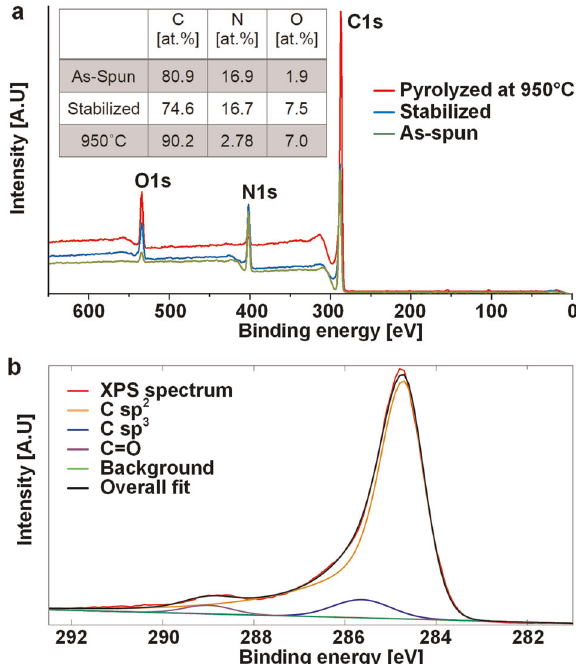
Fig. 3 XPS analysis. a Spectra of as-spun nano fi bers, stabilized nano fi ber bundles and nano fi ber bundles pyrolyzed at 950 °C.